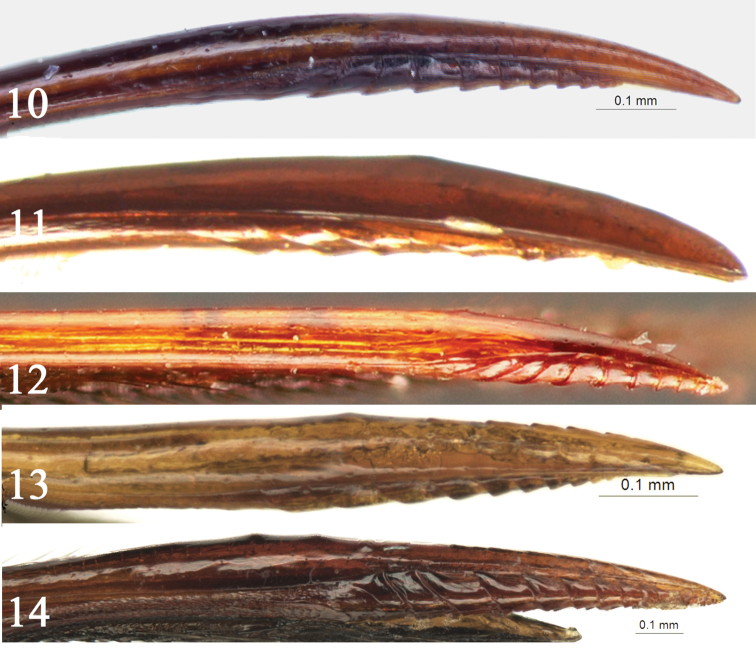
Apical part of ovipositor, lateral view 10Townesia
sulcata Sheng & Li, sp. nov. 11Townesia
cheni Liu & He 12Townesia
exilis Gupta & Tikar 13Townesia
qinghaiensis He 14Townesia
tenuiventris (Holmgren).